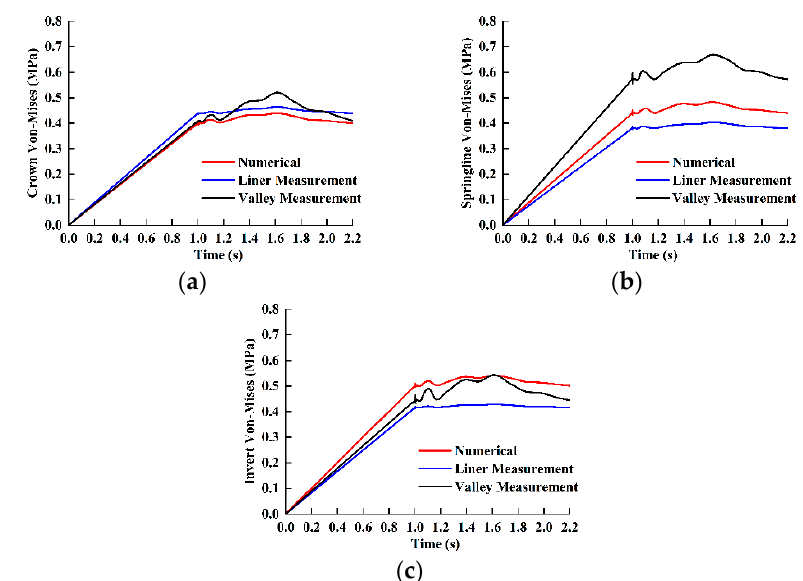
Figure 27. Comparison of measurement and numerical simulation of pipe Von-Mises stress under traffic load: ( a ) the crown; ( b ) the springline; ( c ) invert.